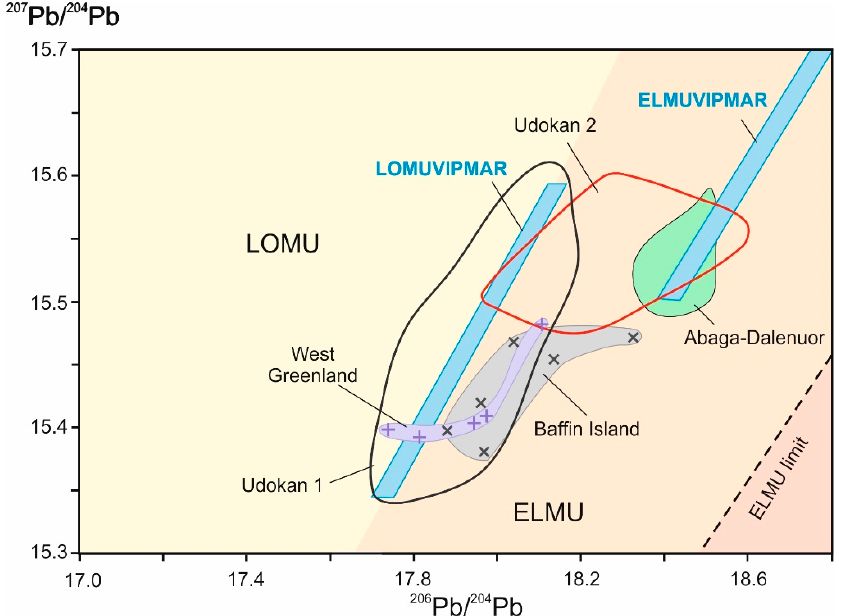
Figure 12. Diagram of 207 Pb/ 204 Pb versus 206 Pb/ 204 Pb for comparisons of Hadean volcanic rocks (Buffin Island and Western Greenland) and Hadean sources of volcanic rocks (Udokan 1, 2 and Abaga-Dalenuor). Data fields of volcanic rocks, the LOMUVIPMAR and ELMUVIPMAR compositions, as well as LOMU – ELMU and ELMU limit discriminate lines are shown as in Figure 5. Data are from [14,53,122].